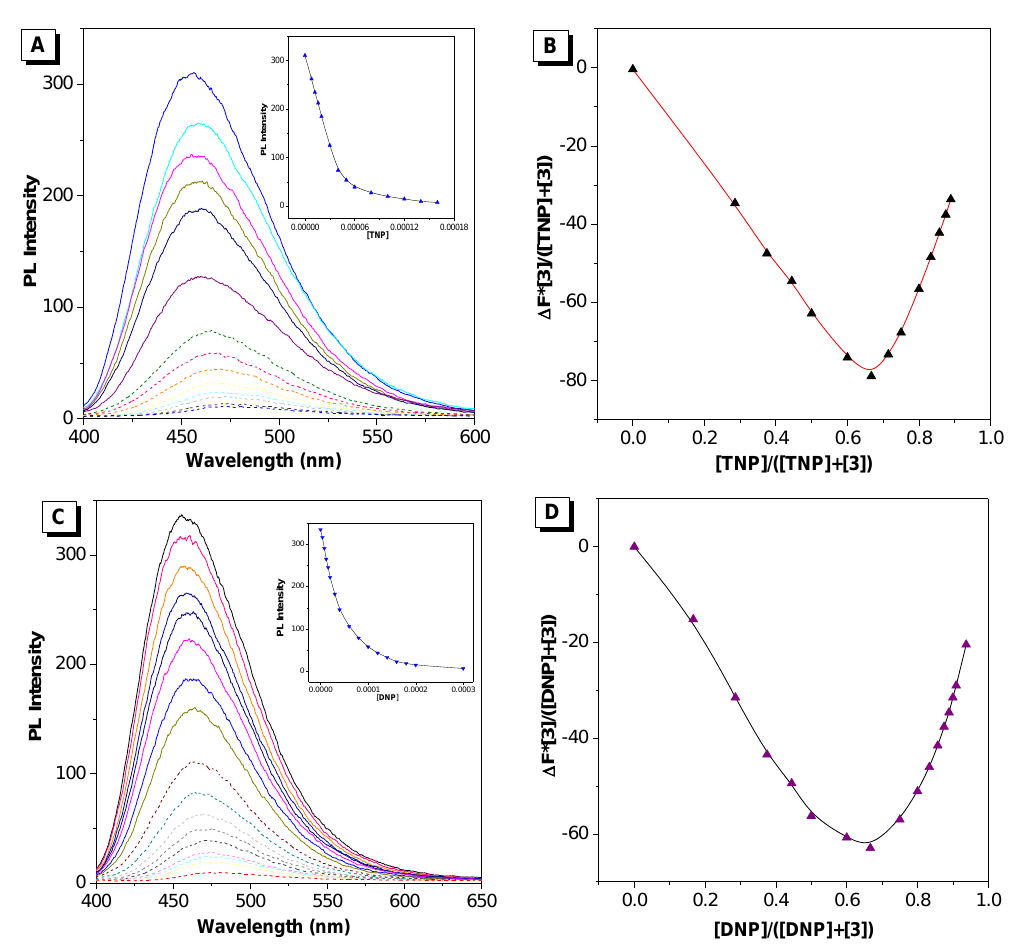
Figure 3. ( A ) The PL spectra of compound 3 with different amounts of TNP. Solvent: H 2 O: THF = 9: 1, [ 3 ] = 2 × 10 − 5 M, [TNP] = 0 – 1.6 × 10 −4 M. Inset: the PL change was observed at 460 nm when compound 3 was combined with TNP. ( B ) The Job’s plot of compound 3 (2 × 10 − 5 M) with TNP at 460 nm. ( C ) The PL spectra of compound 3 with different amounts of DNP. Solvent: H 2 O: THF = 9: 1, [ 3 ] = 2 × 10 − 5 M, [DNP] = 0 – 3 ×1 0 −4 M. Inset: compound 3 fluorescence intensity variation with TNP content at 460 nm. ( D ) The Job’s plot of compound 3 (2 × 10 − 5 M) with DNP at 460 nm. λ ex = 340 nm, ex/em slit widths = 5/5 nm.